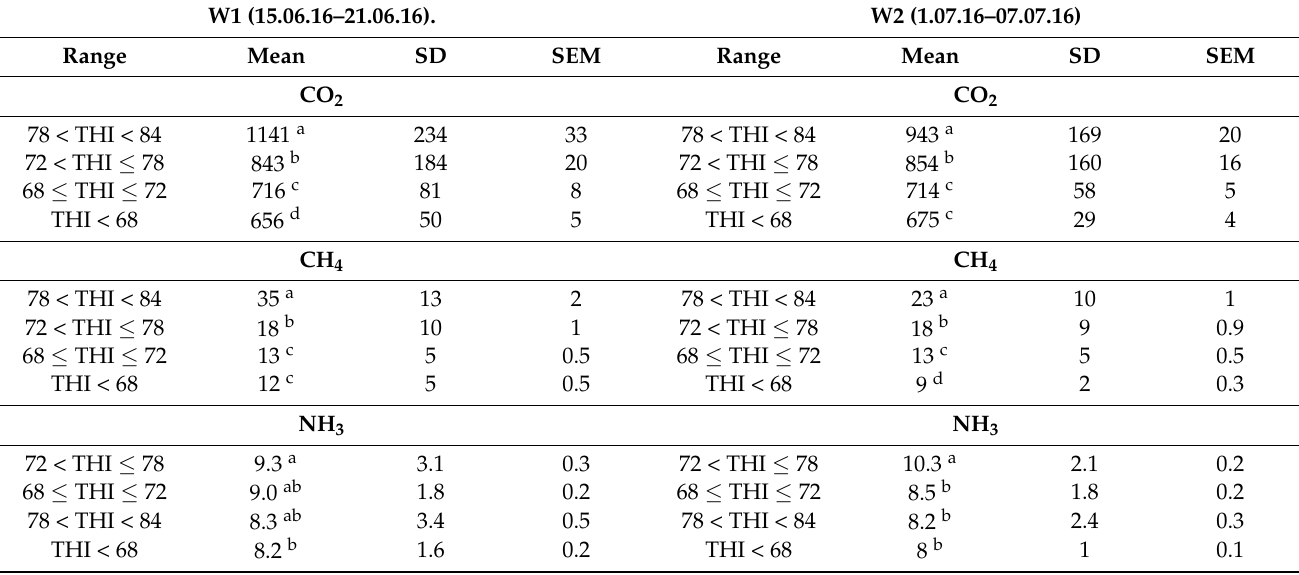
Table 4. Results of statistical analyses for gas concentrations (ppm) of CO 2 , CH 4 and NH 3 , in the central SLs, at different ranges of temperature-humidity index (THI), for low airflow velocity values (v ≤ 0.5 ms − 1 ). Groups of values that do not share a letter (a, c, b, d) are significantly